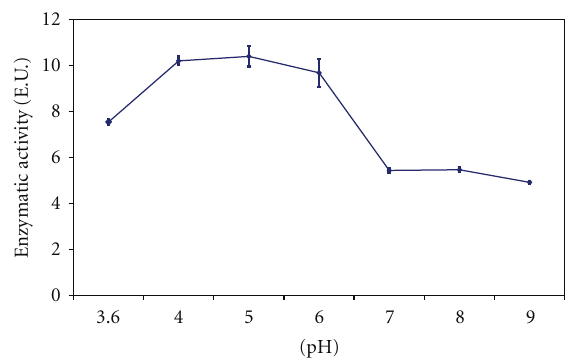
Figure 3: E ff ect of pH on immobilization of HRP in 5mg of PANImG. Bu ff ers used: 0.1 mol L − 1 sodium acetate (pH 3.6–5.0); sodium phosphate 0.1 mol L − 1 (pH